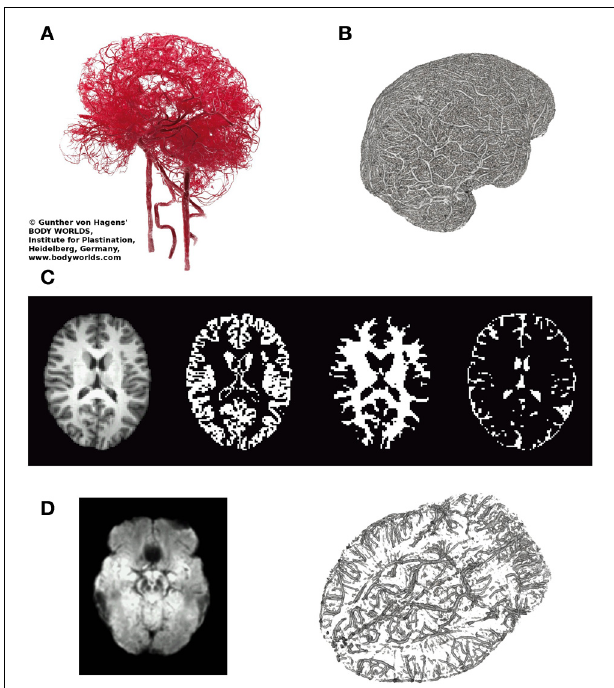
FIGURE 2 | Illustrates relevant macroscopic components in BOLD-based fMRI of the brain. (A) Arterial vessels ex vivo (copyright Gunther von Hagens, Körperwelten, Institut für Plastination, Heidelberg, www.koerperwelten.de), (B) MR-venography of venous vessels in vivo at 7 Tesla [courtesy Dr. M. Barth; adapted from Koopmans [36]]. (C) Representative slice across the brain of a young healthy subject. T1-weighted structural image, segmented gray matter mask, segmented deep white matter mask and segmented CSF space (from left to right). Note that in contrast to (A,B) , vessels are almost invisible. (D) Mean SWI ( n = 3, left), highlighting brain regions with strong susceptibility differences (dark regions) causing artifacts (e.g., frontal lobe/nasal cavities, temporal lobe/ear canals, veins near the brain stem, etc.). MR-venogram ( n =